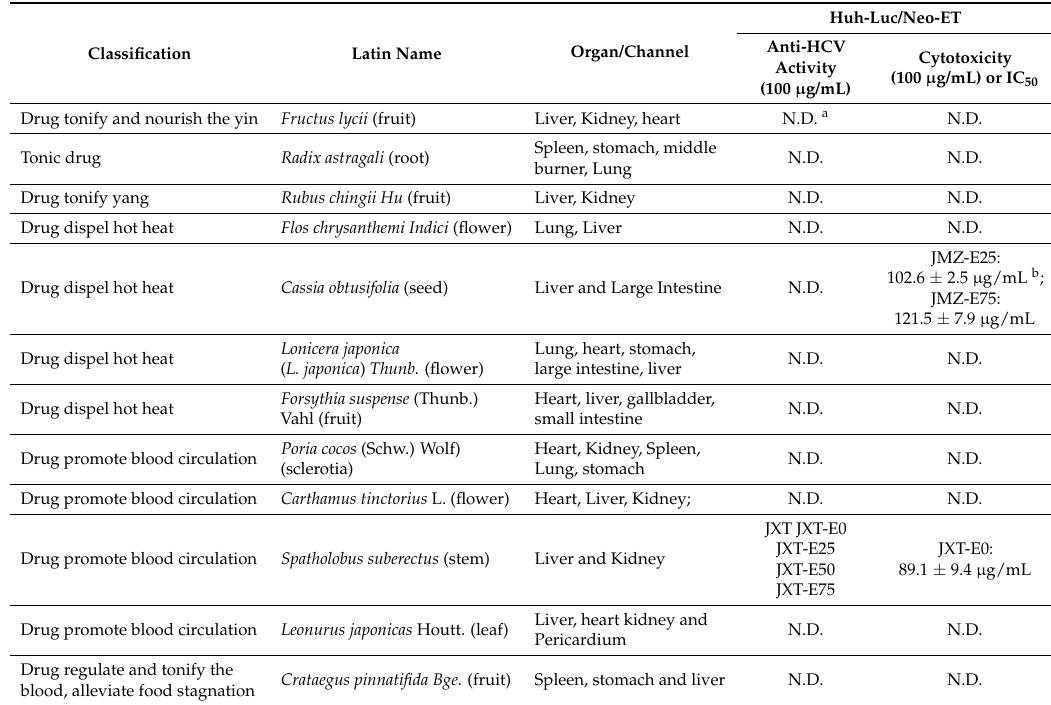
Table 1. Herbs determined in the present study. Impact on HCV replication was evaluated in Huh-luc/neo-ET cells for 72 h and determined following the methods described in the Materials and Methods section.